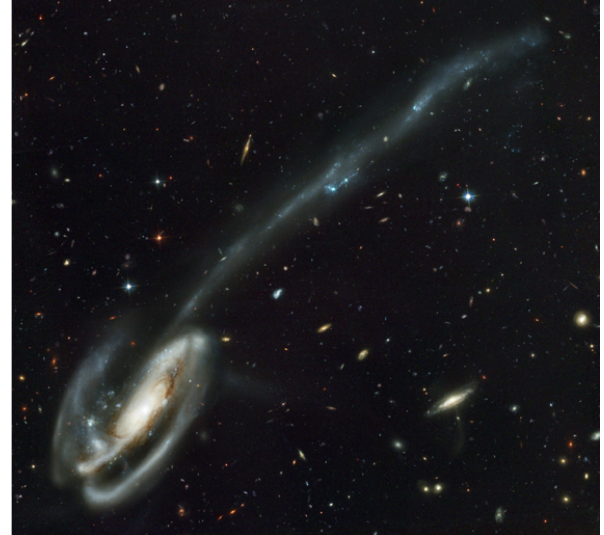
Figure 12. Hubble Space Telescope image of anomalous galaxy, UGC 10214.